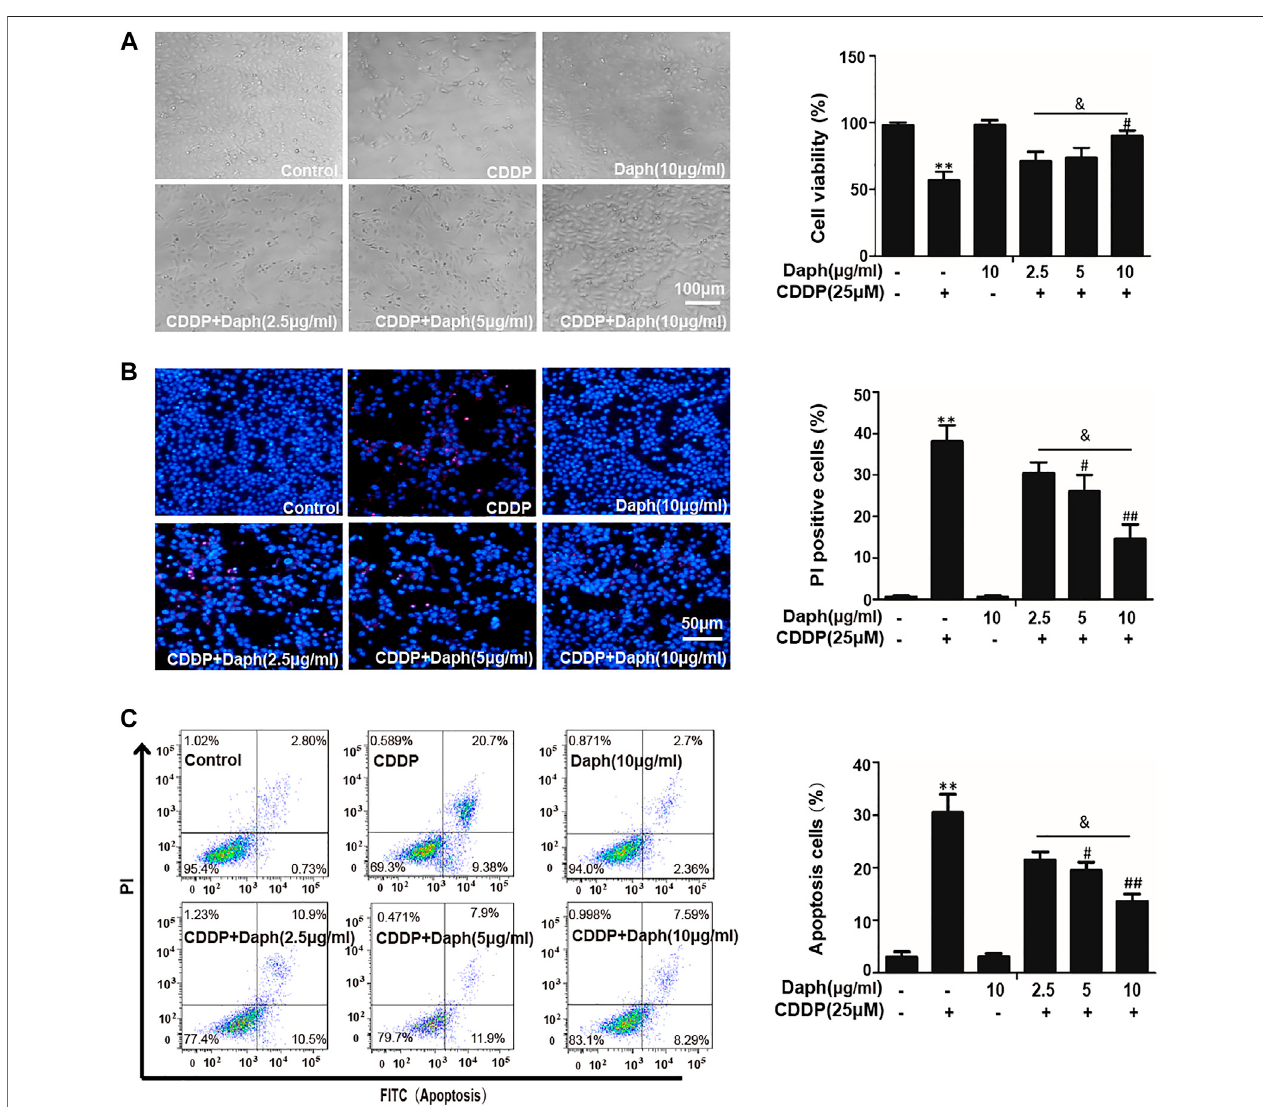
FIGURE 7 | Daph attenuated CDDP-induced cell viability and apoptosis in HK2 cells. (A) Effects of Daph (2.5, 5 and 10 μ g/ml, pretreatment for 1 h) on CDDP (25 μ M, 18 h) induced cell death was analyzed by CCK8. (B) Hoechst/PI staining assay was used to detect the effects of Daph on CDDP induced apoptosis. (C) Flow cytometry was used to detect the effects of Daph on CDDP induced the percentages of apoptotic and necrotic cells. Data are presented as the mean ± SEM, and are representative ofthree independent experiments. * p < 0.05 and ** p < 0.01 vs. the control group; # p < 0.05 and ## p < 0.01 vs. the CDDP group; & p < 0.05 vs. the Daph (10 μ g/ml) plus CDDP